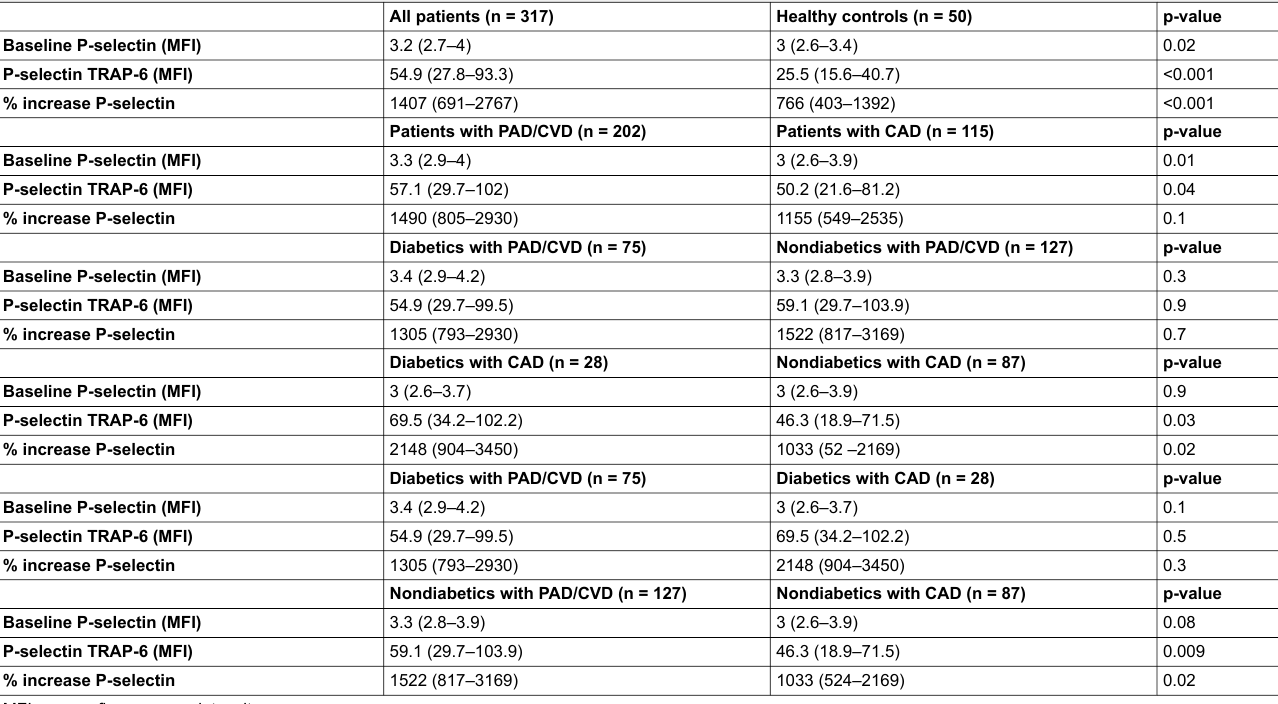
Table 2: Median and interquartile range of baseline P-selectin, thrombin receptor activating peptide-6 (TRAP-6) inducible P-selectin (P-selectin TRAP-6), and relative increase of platelet P-selectin after stimulation with TRAP-6 (% increase P-selectin) in the overall patient population, in healthy controls, in patients with peripheral artery disease / cerebrovascular disease (PAD/CVD) and coronary artery disease (CAD), in diabetics and nondiabetics with PAD/CVD, and in diabetics and nondiabetics with